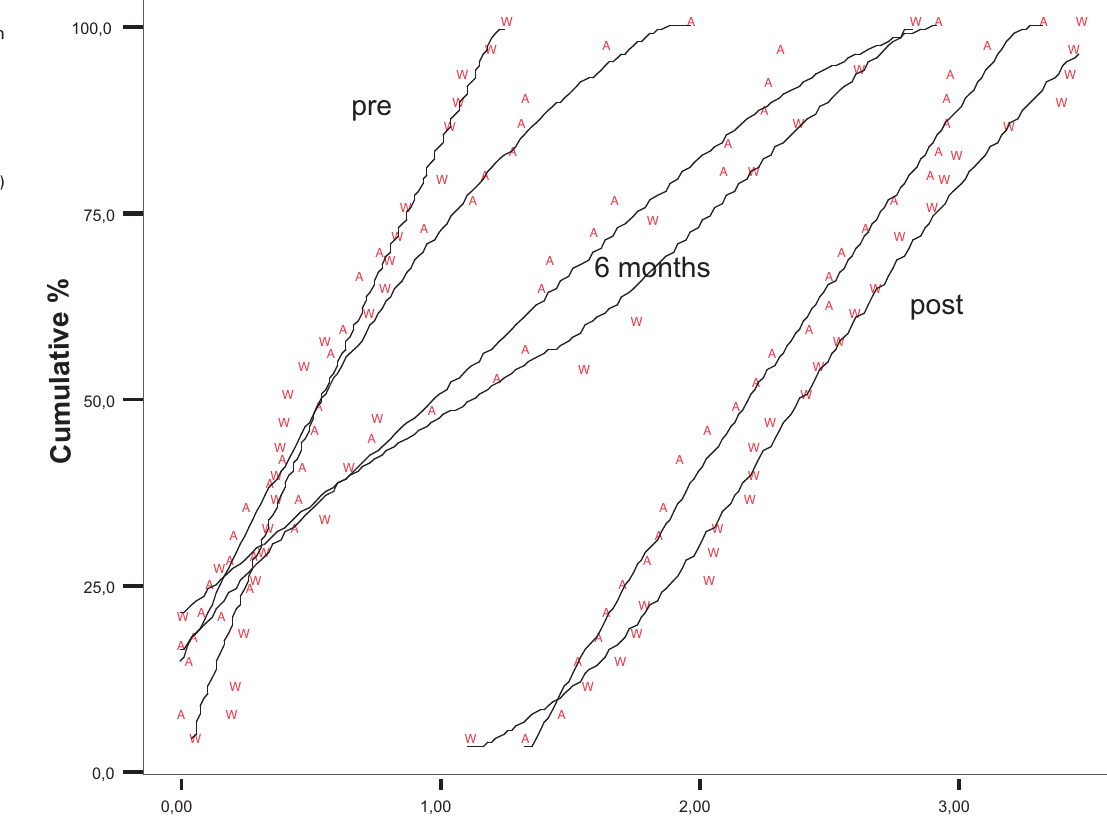
Distribution of lesion minimal lumen dia- meters at baseline (pre), immediately after the interven- tion (post), and at 6 months in patients assigned IVUS (bold) or angiographic